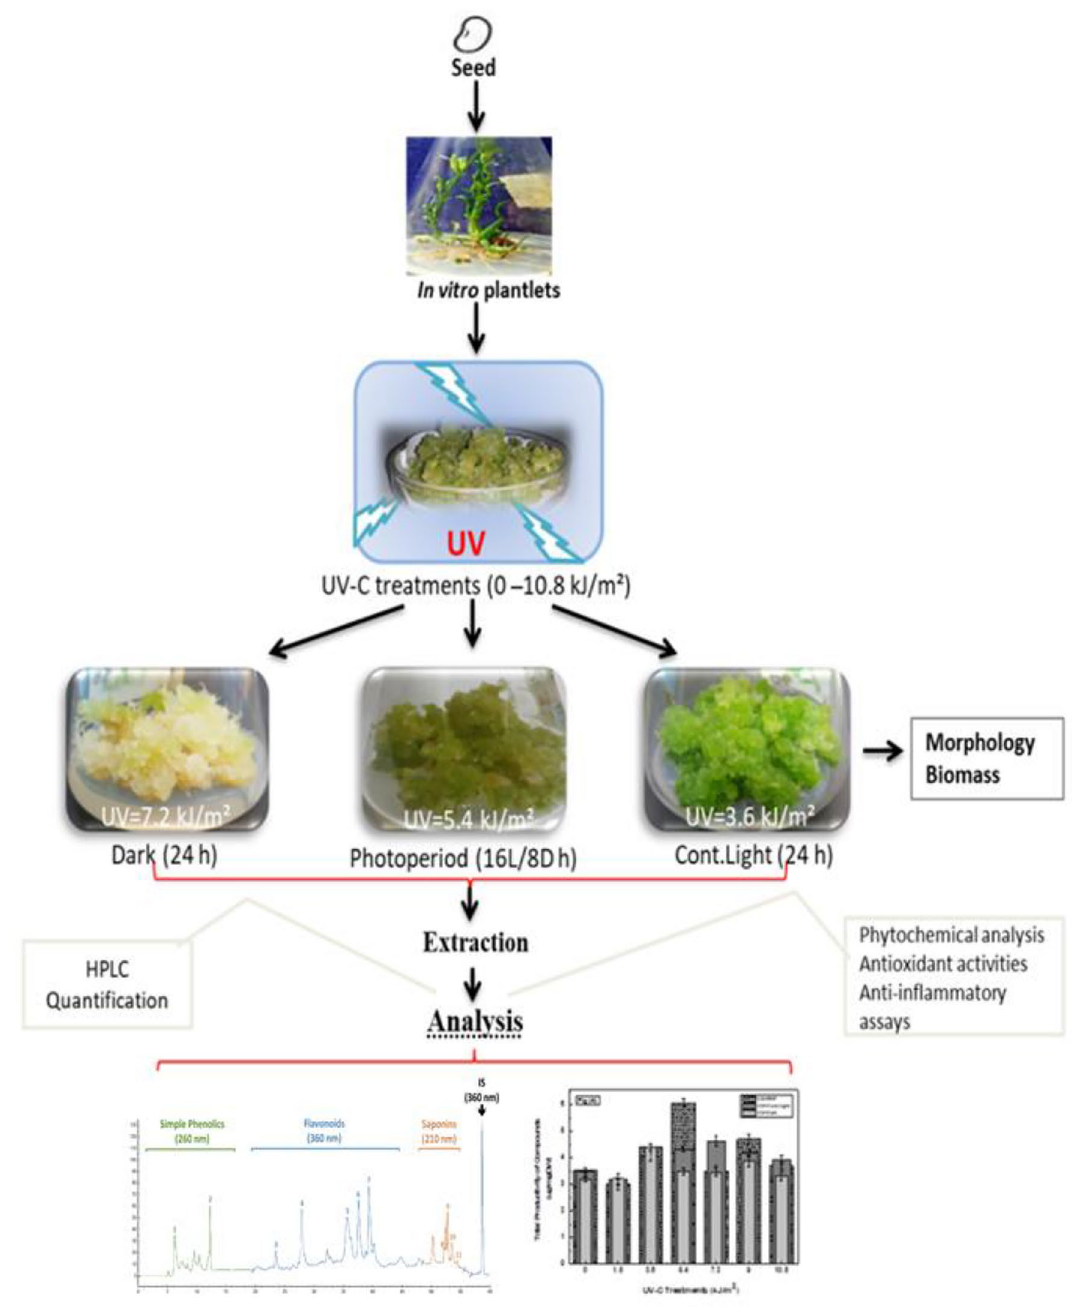
Figure 8. Graphical represenation of synergistic effects of UV-C treatments (0–10.8 kJ/m 2 ) and light regimes (cont. light (24 h) and complete dark (24 h) on callus cultures of Fagonia indica